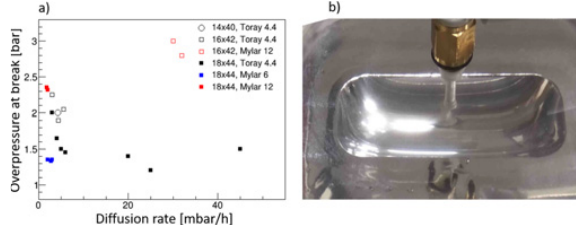
Figure 8. (a) Test results showing the dependence between the beak point pressure and diffusion rate at one bar overpressure for a few different window sizes and foil materials. (b) Window deformation in the test setup.